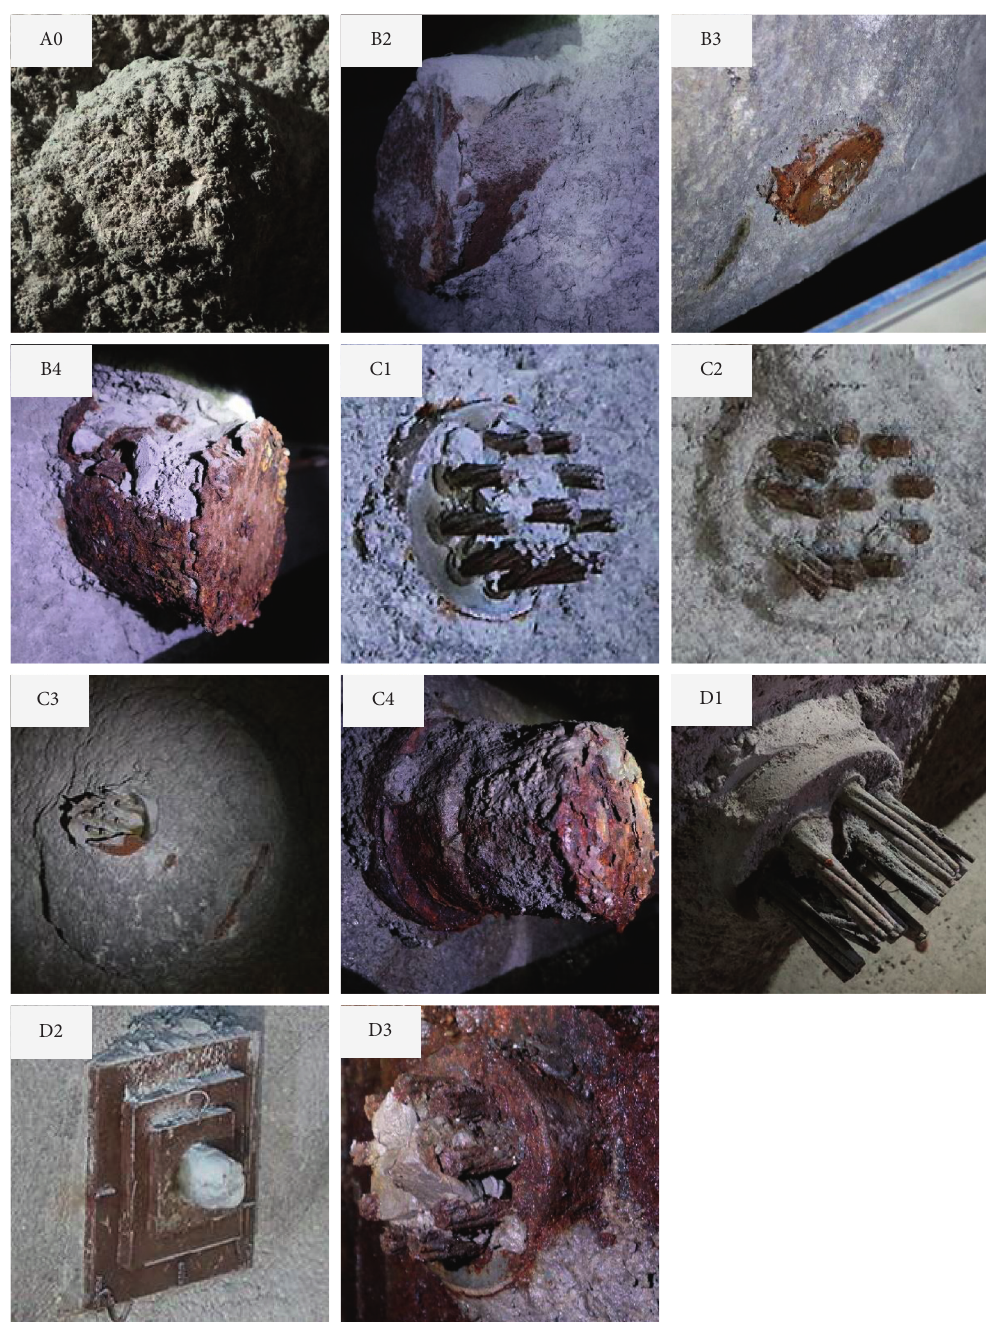
Figure 12: Anchor heads with different combined